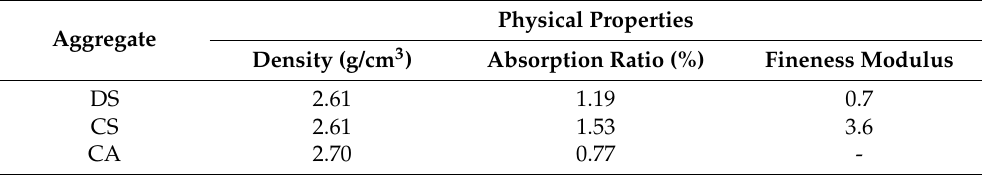
Table 2. Physical properties of aggregates.